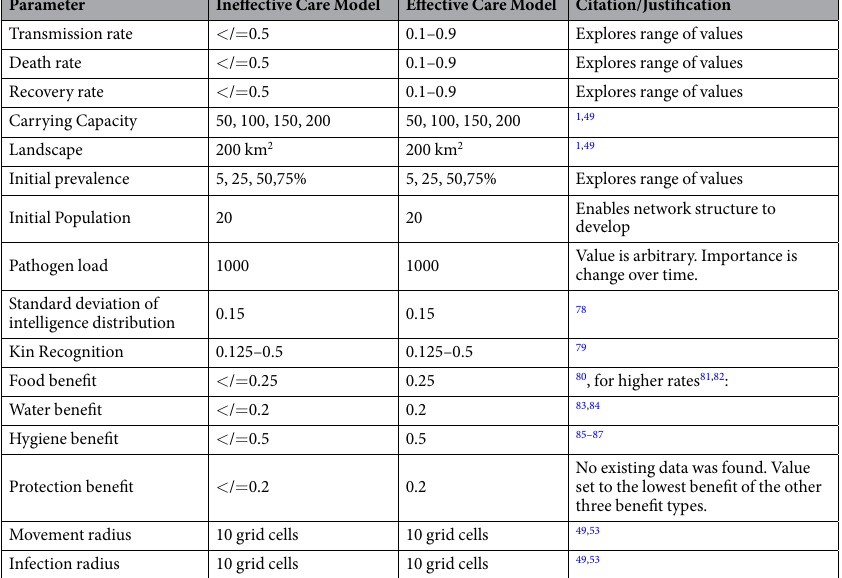
Table 1. Parameters used in the Ineffective Care Model and the Effective Care